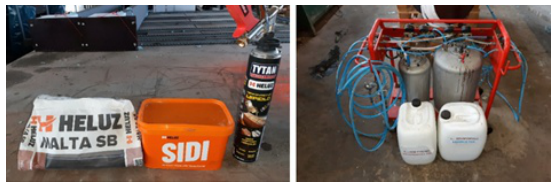
Figure 2. The selected adhesives: B – HELUZ SB mortar for a thin joint, A – HELUZ SIDI, C – HELUZ TYTAN PUR foam (thin-film adhesive), E – PU-contact two-component adhesive.